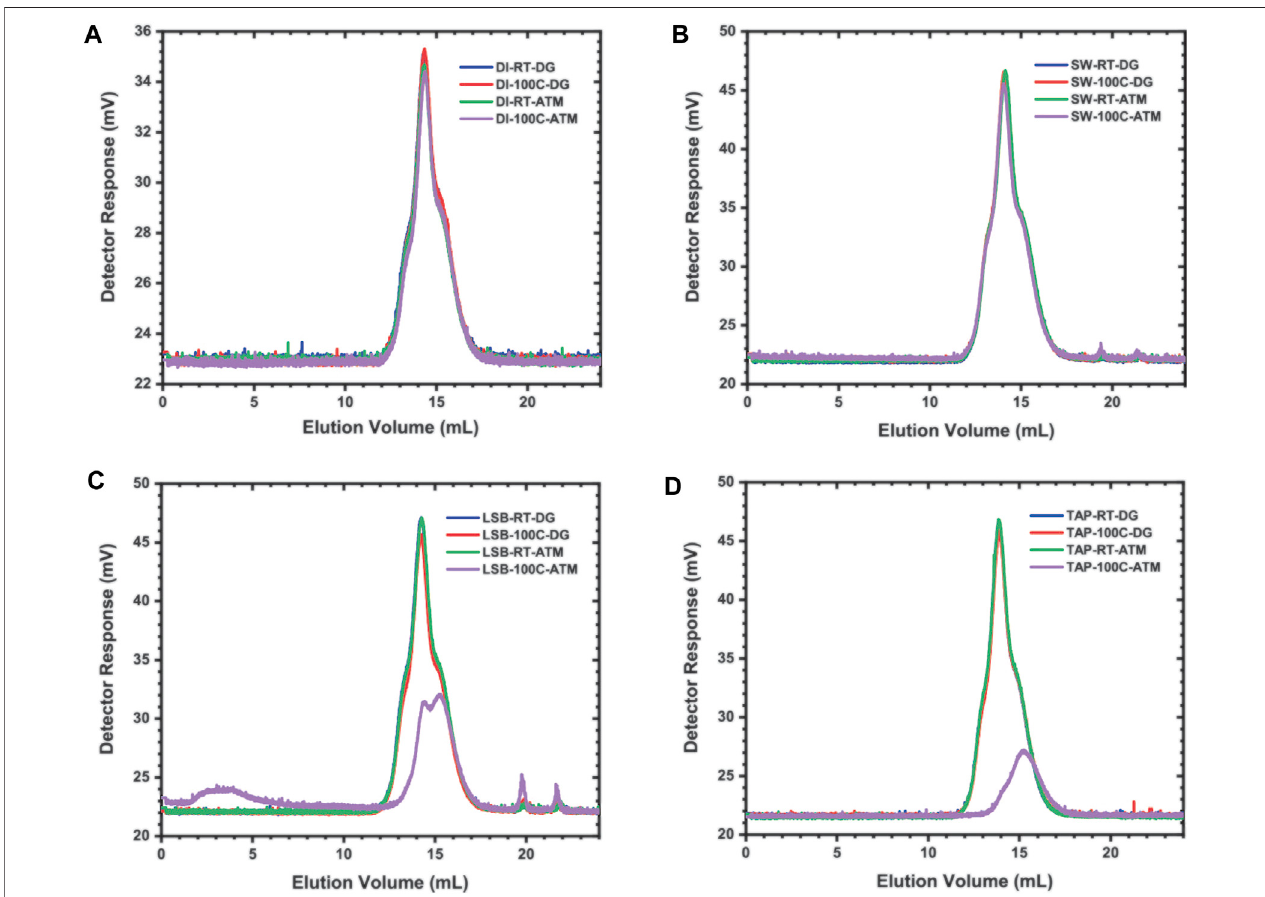
FIGURE 6 | GPC chromatograms depicting elution of dextran dissolved in deionized water (DI), seawater (SW), low-salinity brine (LSB) and tap water (TAP), including elution of its molecular weight fragments. RT = room temperature, 100C = heated sample, DG = degassed (purged with N 2 ), ATM = sealed under regular